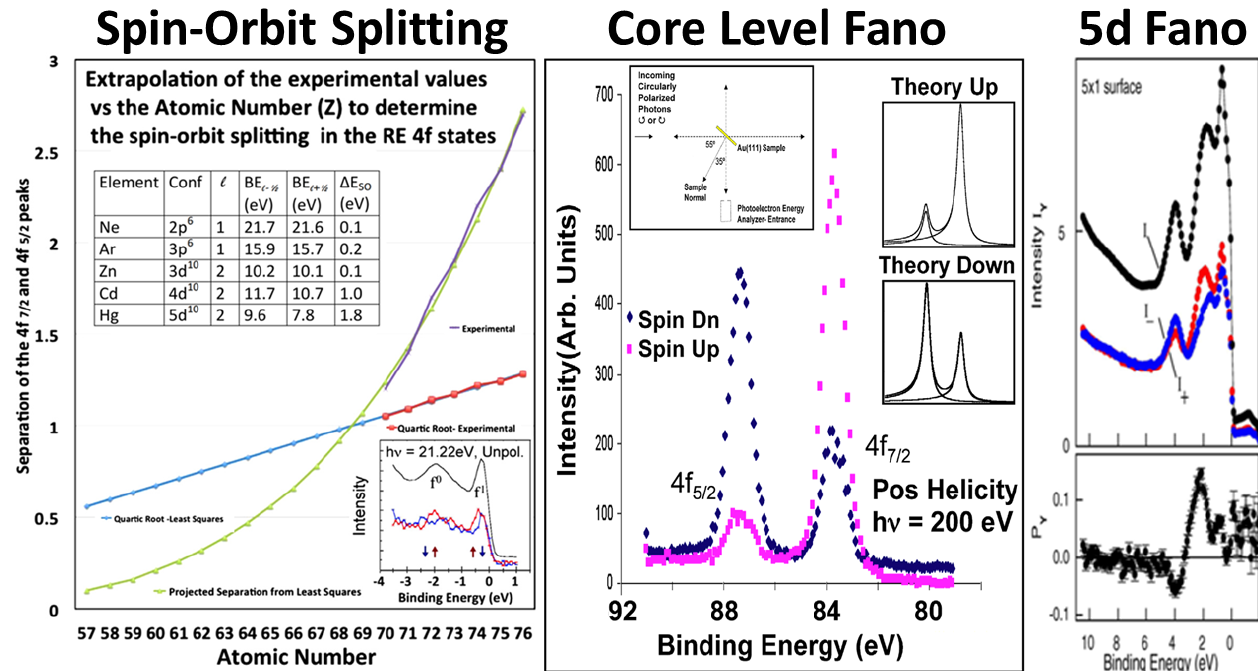
Figure 10. (Left Panel ) The spin-orbit splittings in the RE’s and some other atoms are shown here. For the rare earths, the spin-orbit splitting used here is the energy separation of the 4f 7/2 and 4f 5/2 peaks. The table uses data from Reference [44]. The Fano spectral data in the inset are from References [45,46]. They are consistent with the extrapolated value of ~0.2 eV for the 4f spin orbit splitting in Ce. The panel was taken from Reference [37]. ( Middle Panel ) Fano effect results for Au 4f core states with circularly polarized photons and true electron spin detection. The experimental spin resolved results are shown in color. The experimental geometry diagram is in the inset in the upper left and the results of a simple theory are in the insets in the upper right. See References [45,46] for details. (Right Panel) Pt 5d Fano from Reference [47], using unpolarized HeI and a chiral configuration of vectors, is shown here. Spin-resolved photoemission spectra obtained with unpolarized HeI (hv = 21.2 eV) light for normal emission from the valence-bands of Pt(001). The spin integrated total intensity I (black) and spin separated partial intensities I+ in red and I − in blue are shown for 5 × 1 surface. The measured spin polarization P Y for a 5 × 1 surface is also shown.